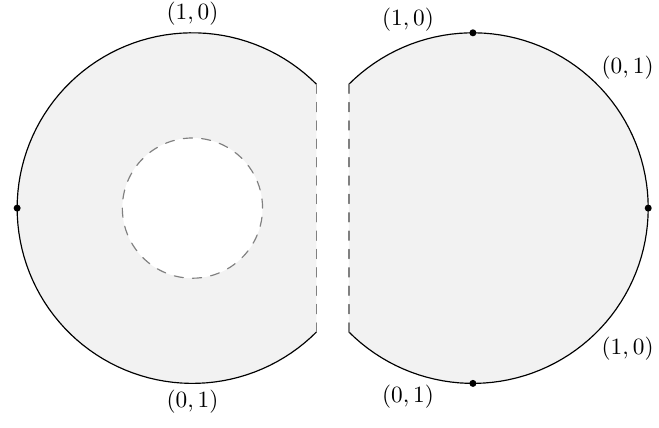
Figure 3 . Rod diagram for the connected sum of S 4 \ T 2 × B 2 and S 2 × S 2